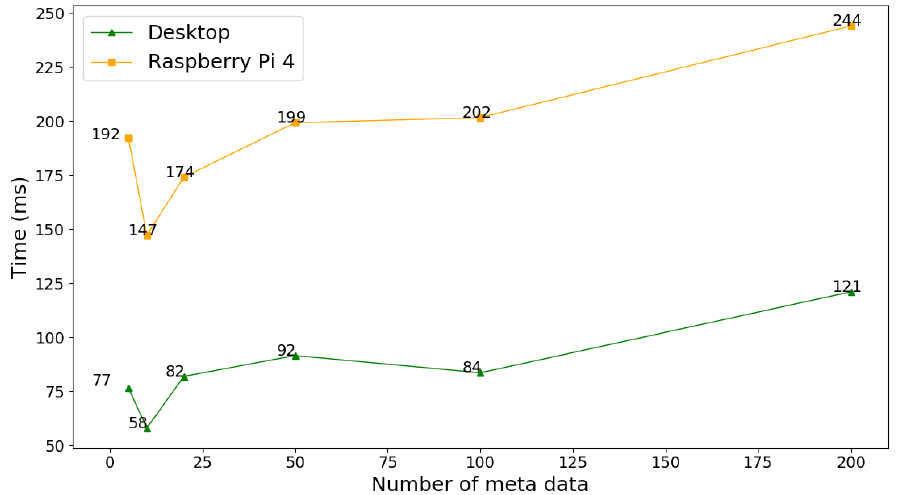
Figure 5. Latency by data token query on different platforms.